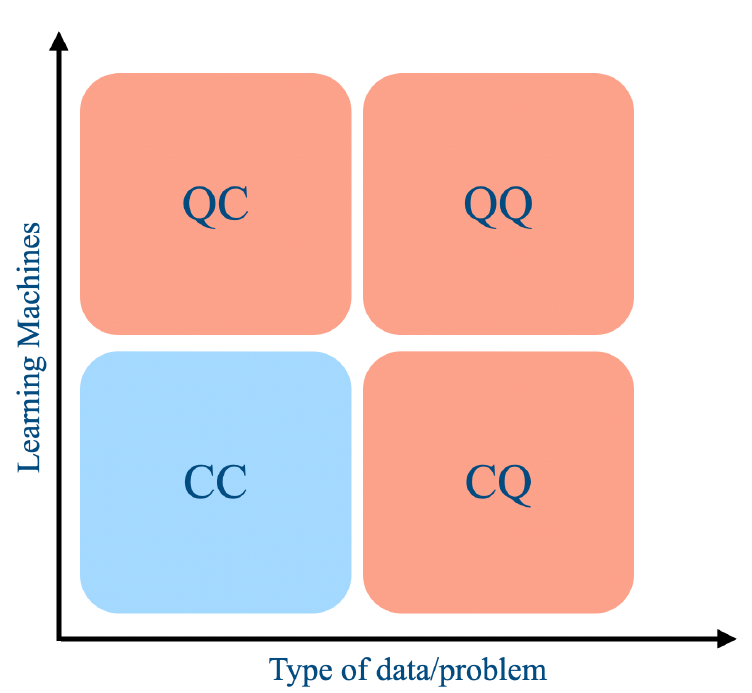
Figure 2. A bird’s eye view of quantum machine learning landscape. The first letter on each square indicates the type of data or problem, while the second letter indicates the model applied on the data. Thus, in this landscape, the orange squares indicating the use of quantum models either on classical or quantum data or use of classical models on quantum data can be considered as quantum machine learning, while the blue square indicating the use of classical models on classical data indicates the traditional machine